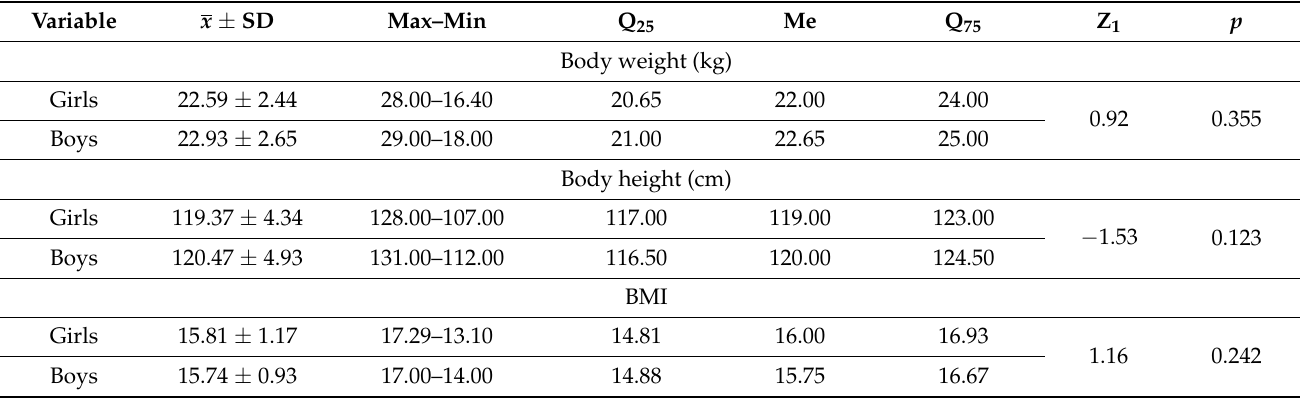
Table 1. Comparison of somatic characteristics of the examined girls and boys.